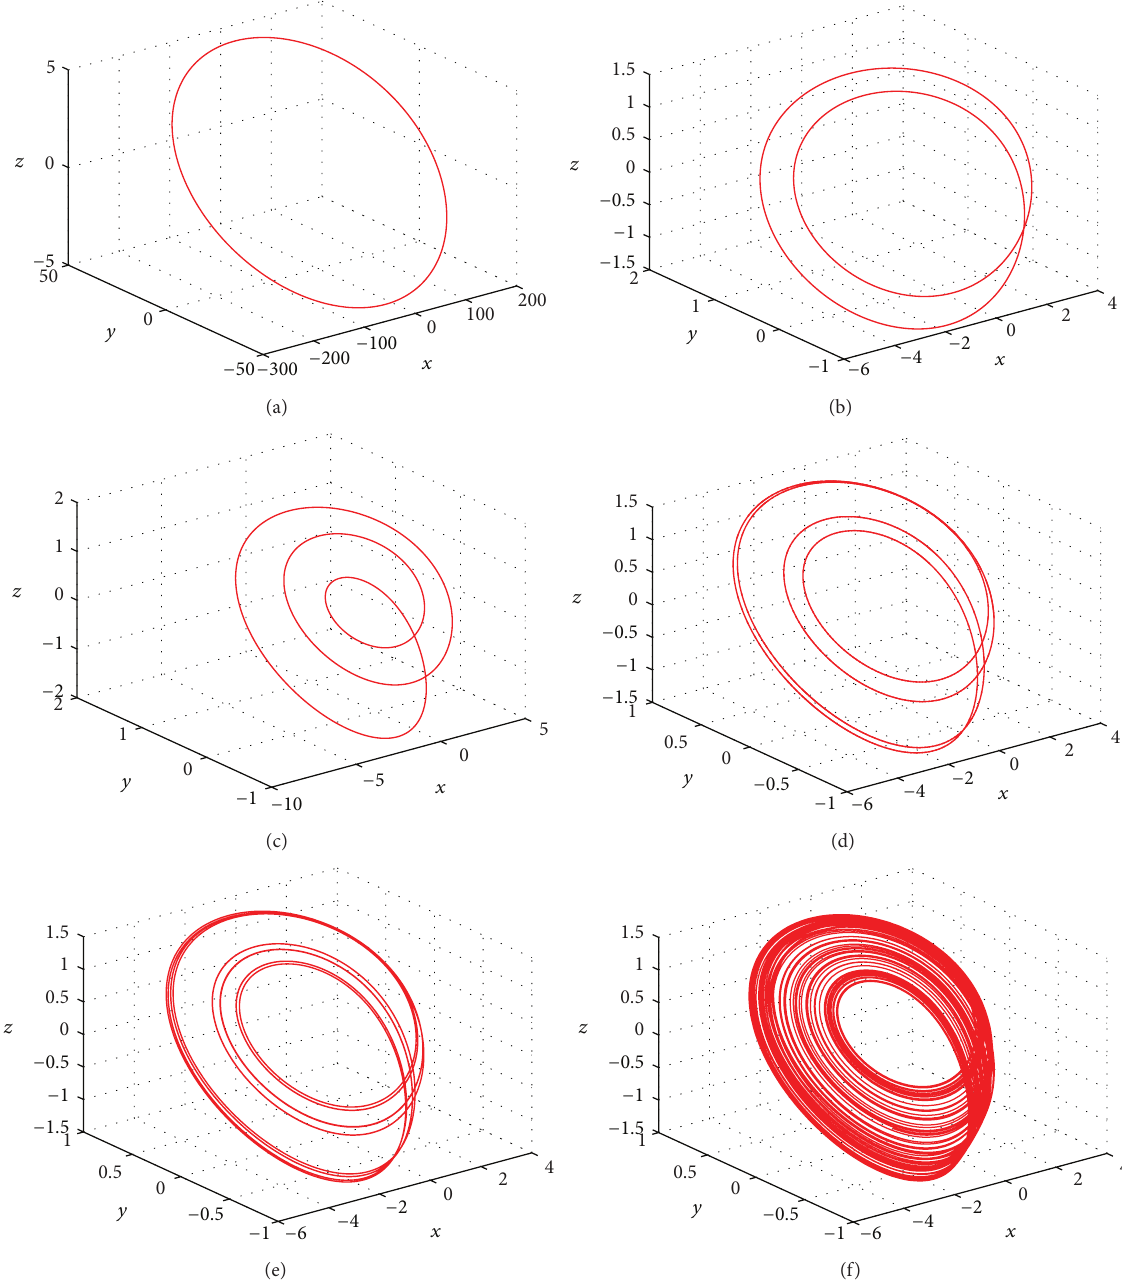
Figure 3: Phase portraits of system (1): (a) period 1, 𝑐 = 0.1 , (b) period 2, 𝑐 = 1.3 , (c) period 3, 𝑐 = 1.36 , (d) period 4, 𝑐 = 1.5 , (e) period 8, 𝑐 = 1.52 , and (f) chaotic, 𝑐 = 1.6